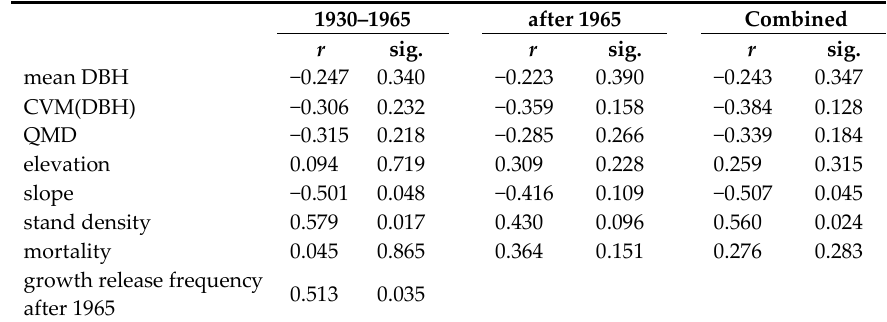
Table 2. Pearson correlation coefficient ( r ) between plot variables and the frequency of growth releases before and after 1965, as well as 1930–2012. 1930–1965 after 1965 C ombined sig. sig.